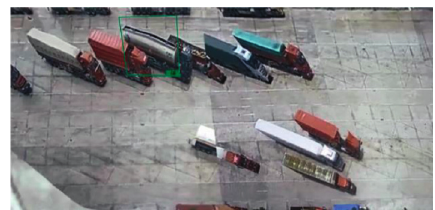
Figure 10: Detection result in the surveillance